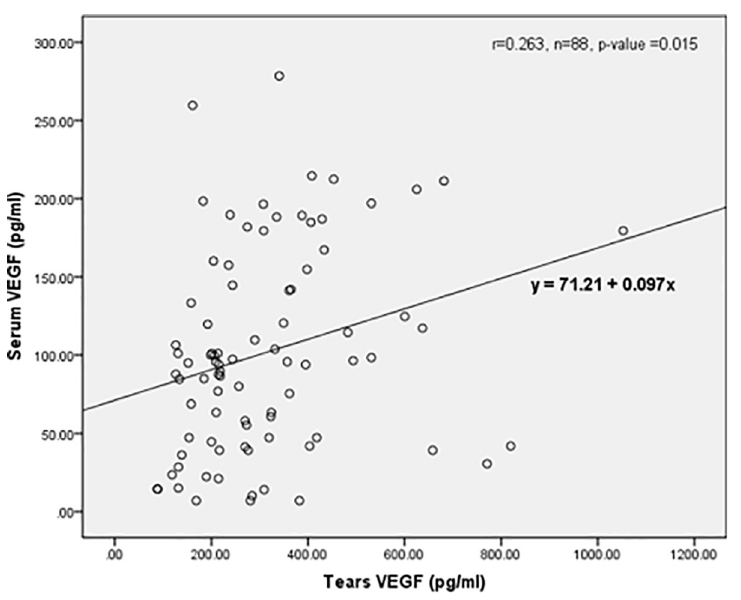
Fig 1. Correlation between serum and tears of VEGF